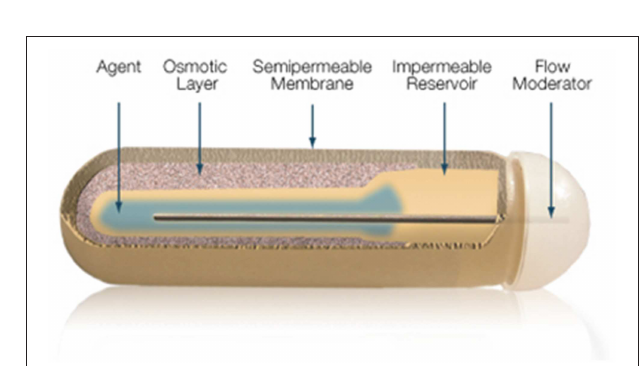
FIGURE 5 | Serum triiodothyronine (T3) levels in hypothyroid rats given 24 µ g/kg body weight LT3 or equimolar amounts of PZL through gavage; adapted fivm Da Conceicao et al. (38).